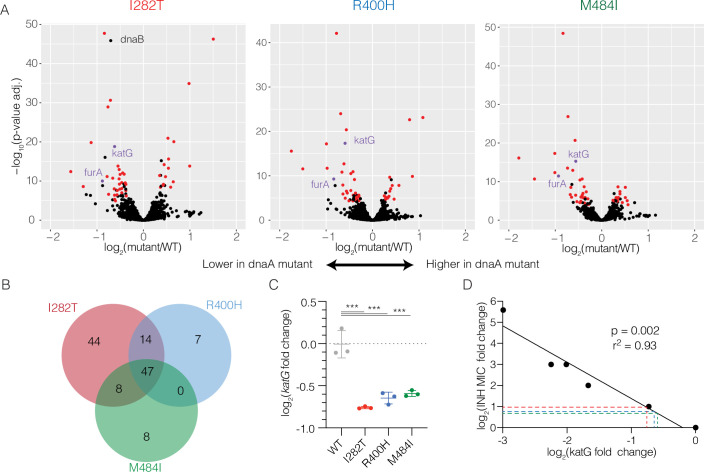
Profiling of dnaA mutants implicates katG expression in INH resistance.(A) Genome-wide differential gene expression analysis with RNA-seq. Log2 fold changes are shown with increased expression in dnaA mutants to the right and decreased expression to the left. q-values calculated by DE-Seq analysis. Genes discussed in the text are highlighted. (B) The number of differentially expressed in each strain at q < 0.0001 compared with WT. (C) Nanostring measurement of katG expression normalized to composite expression of atpH and sigA using Nsolver software. Differences in mean expression tested by Holm-Sidak’s multiple comparison test after one-way ANOVA. *** is p < 0.001. (D) INH MIC correlates with katG expression across CRISPRi mediated knockdown. Each point represents the average of two measurements from 6 different CRISPRi strains with variable levels of katG knockdown. Dashed lines indicate the expected change in MIC for dnaA mutants based on observed katG expression changes.